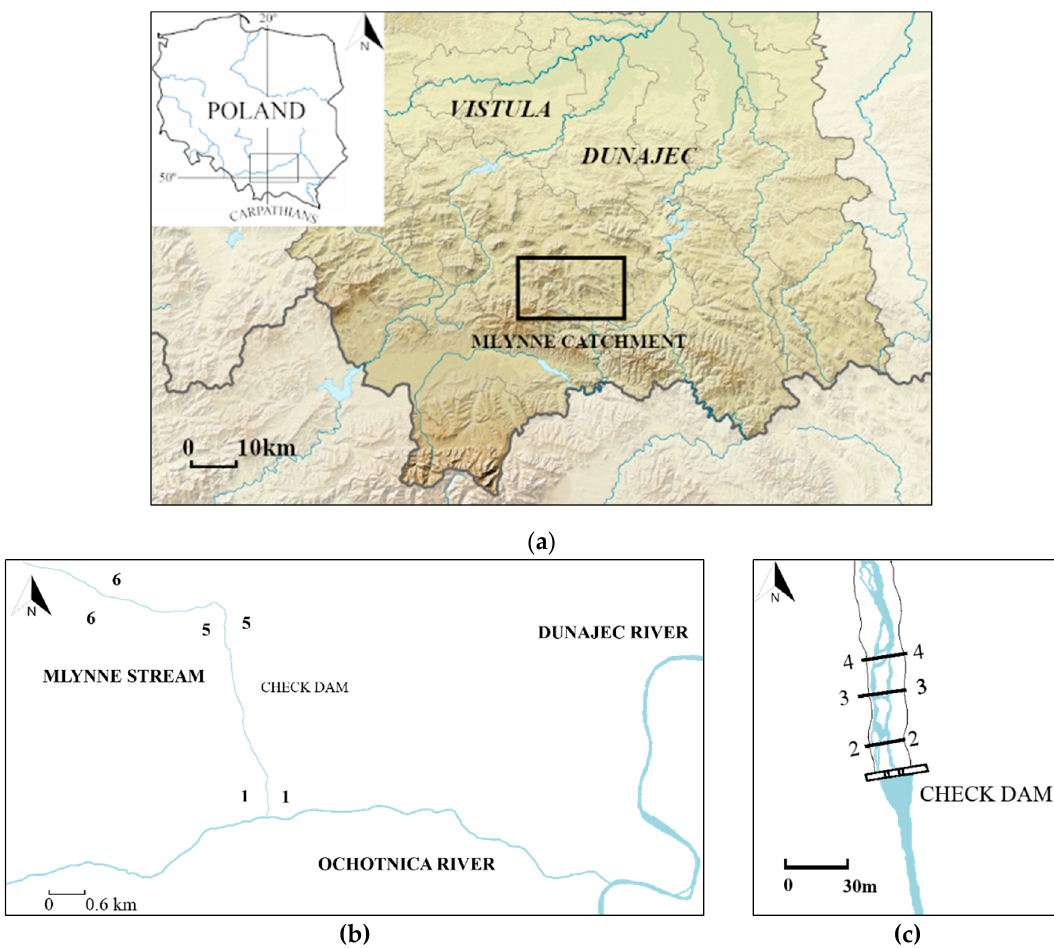
Figure 1. Location of the Mlynne Stream catchment ( a ); the chosen research cross sections and research reach ( b ); check dam cross sections details ( c ).